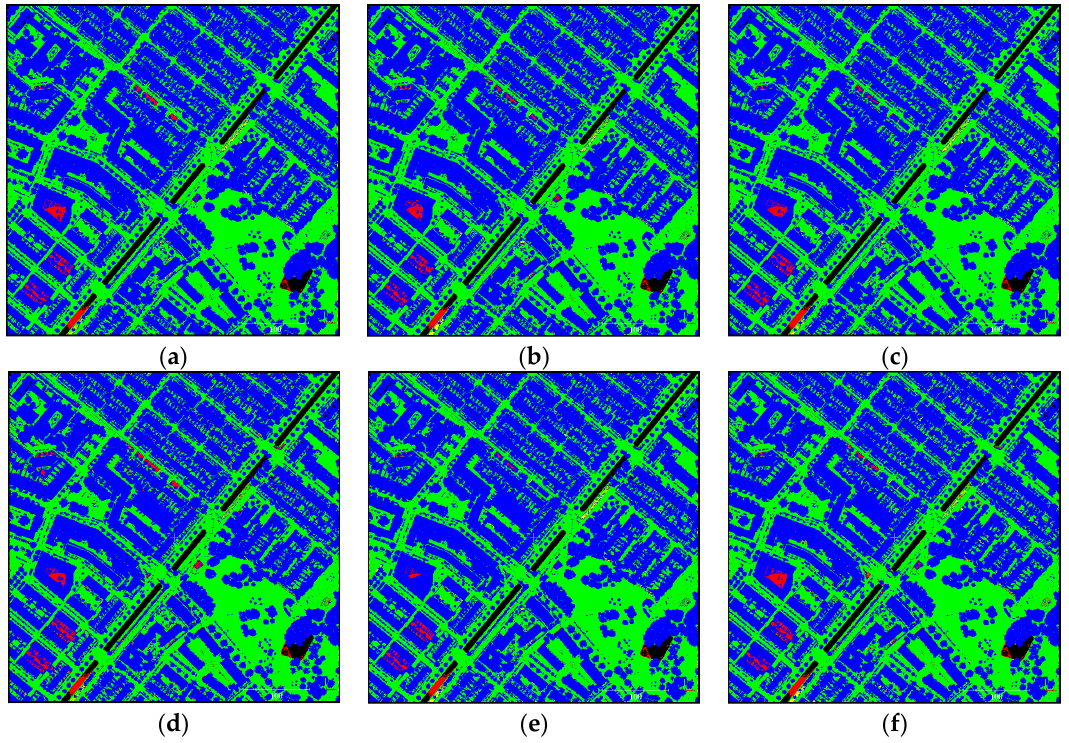
Figure 10. Ground classification results on testing sample number 7 (TS7) of the Actueel Hoogtebestand Nederland 3 (AHN3) dataset: ( a ) FCN 1 m; ( b ) FCN 0.5 m; ( c ) MS-FCN Down; ( d ) MS-FCN Down–Up; ( e ) MTN-FCN; ( f ) LAStools. Green: correctly labeled ground; Blue: correctly labeled non-ground; Yellow: ground point misclassified as non-ground; Red: non-ground point misclassified as ground.